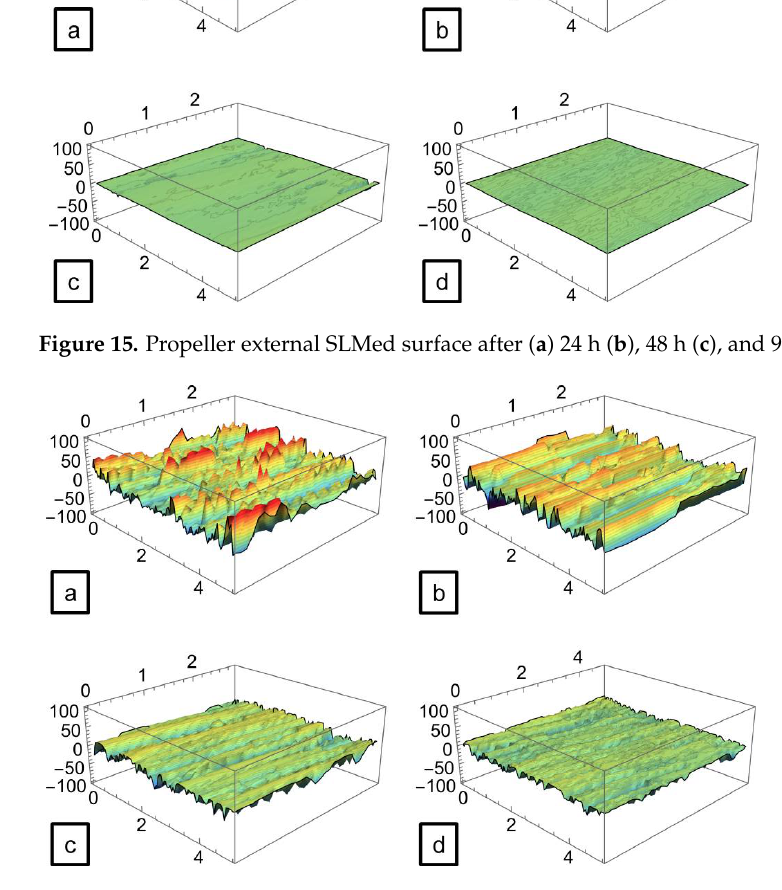
Figure 15. Propeller external SLMed surface after ( a ) 24 h ( b ), 48 h ( c ), and 96 h ( d ) BF working time.